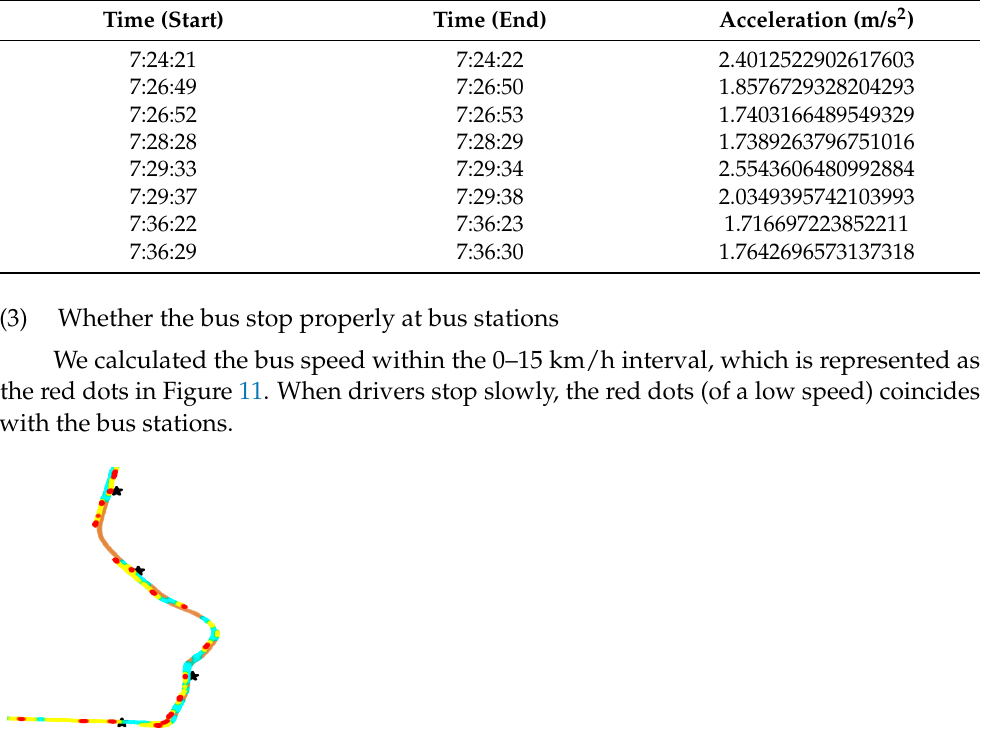
Table 4. Data instances of the acceleration values (m/s 2 ).